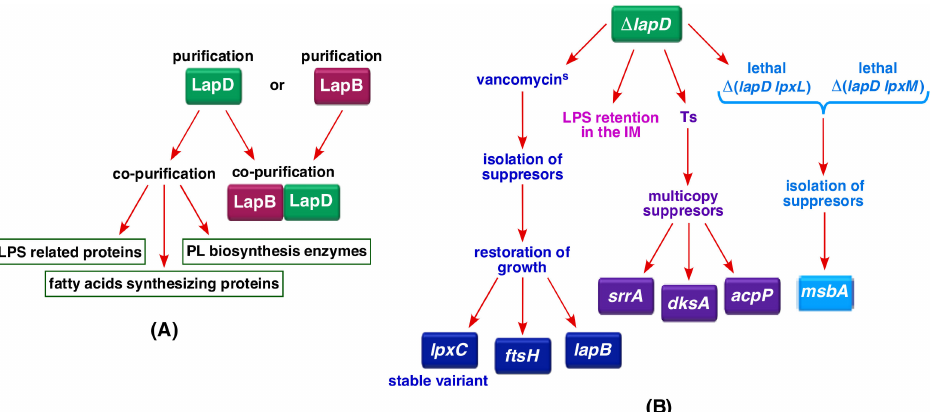
Figure 2. Schematic depiction of various approaches that identify LapD as a regulator of LPS biosynthesis regulating LpxC amounts and assisting MsbA in the LPS transport. Identification of LapD as an IM protein associated with LapB and co-purification of LapD with proteins involved in LPS/phospholipid biosynthesis ( A ). Suppressors of vancomycin sensitivity of ∆ lapD and of various synthetic lethal combinations identify suppressor mutations either in genes that stabilize LpxC or in the msbA gene, revealing that LapD acts upstream of LapB and aids MsbA-mediated LPS transport ( B